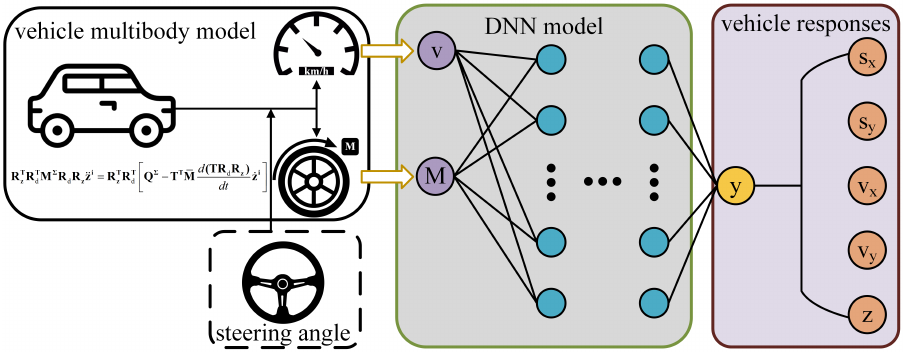
Figure 3. DNN model for vehicle dynamics.